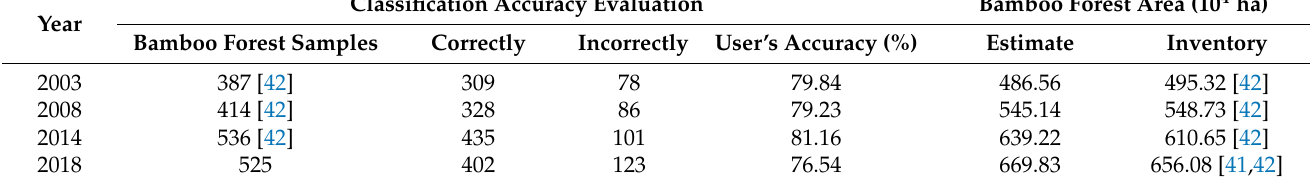
Table 2. Extraction accuracy evaluation and the comparison of estimated and inventory bamboo forest area of